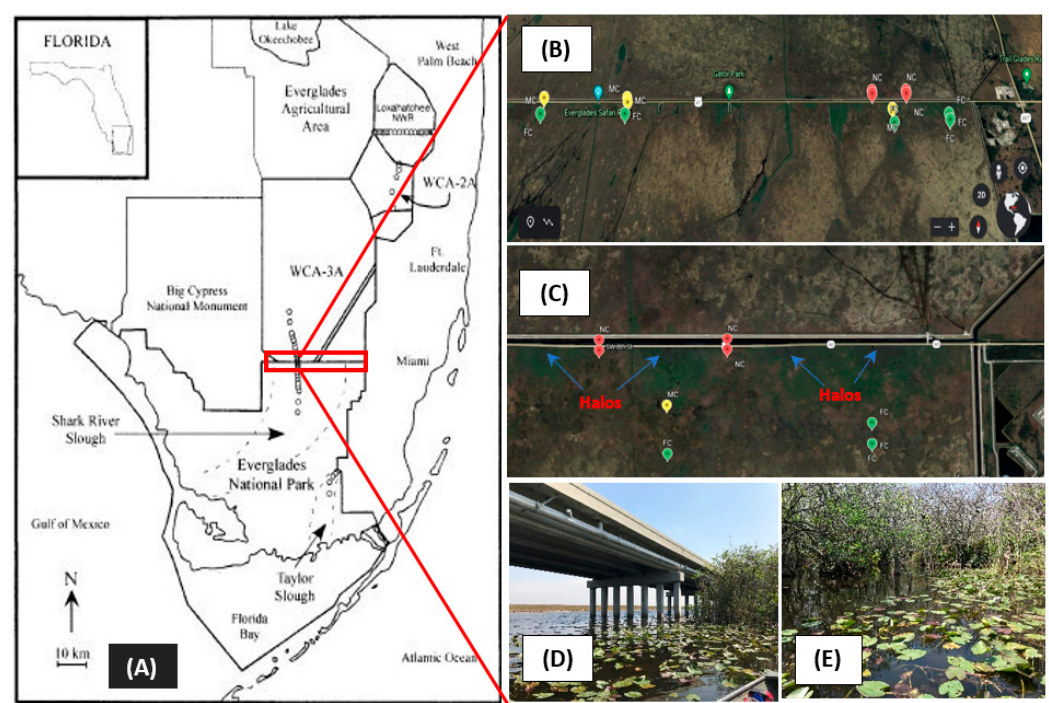
Figure 1. Locations of sampling sites in Northeast Shark Slough (NESS), Florida, USA ( A ), in proximity to a bridge constructed to partially restore southward water flow into Everglades National Park (ENP). Red tags are near-canal sites (0–150 m downstream of canal), yellow tags are midway (150–600 m), and green tags are far from the canal (600–1200 m) ( B , C ). Remnant vegetation “halos” (increased biomass and nutrients) are identified and show the locations of pre-bridge culverts ( C ). Google Earth images were used for context. Photographic images of the bridge (near-canal) ( D ) and sampling site ( E ).